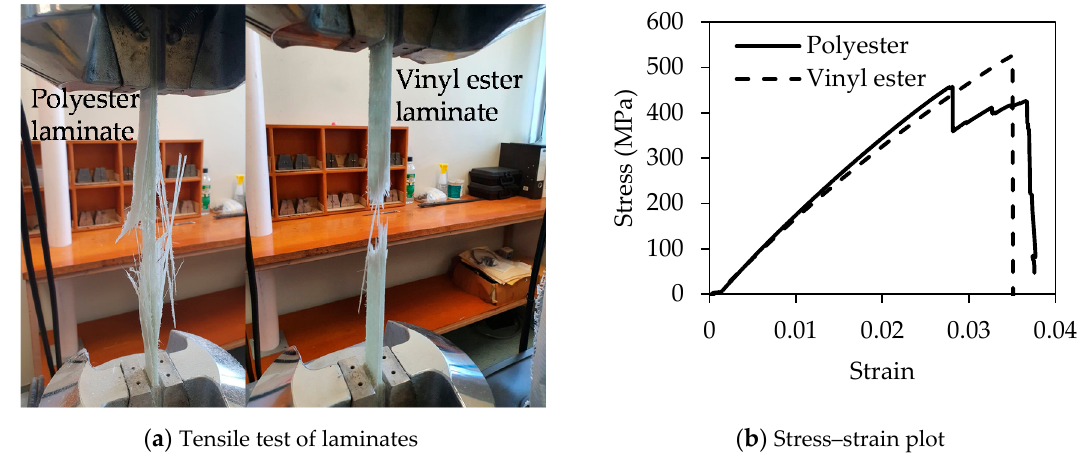
Figure 2. Ultimate test of polyester and vinyl ester based GFRP laminates.